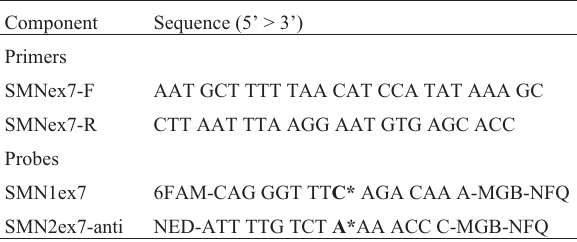
Table 1 - Primers and probes for detecting SMN1 and SMN2 genes using TaqMan ® analysis.